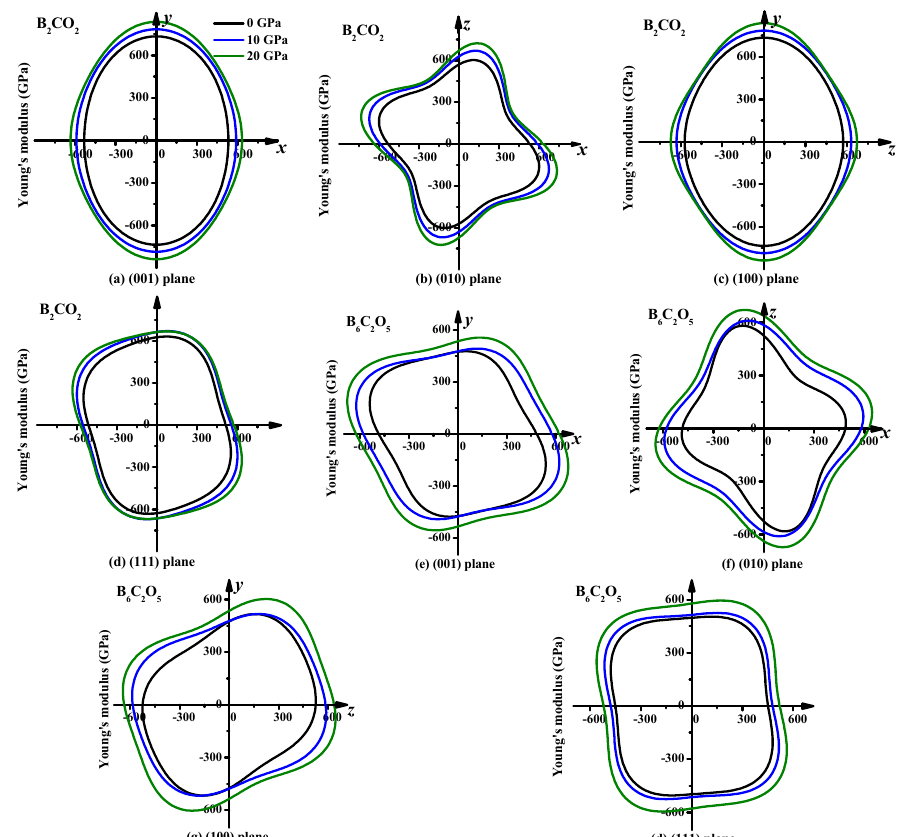
Figure 7. Planar projections of the directional dependence of the Young’s modulus in B 2 CO 2 , ( a ): (001) plane, ( b ): (010) plane, ( c ): (100) plane, and ( d ): (111) plane; and Planar projections of the directional dependence of the Young’s modulus in B 6 C 2 O 5 , ( e ): (001) plane, ( f ): (010) plane, ( g ): (100) plane, and ( h ): (111) plane. Table 3. Calculated the maximum values (in GPa) and minimum values (in GPa) of Young’s modulus and shear modulus and the X max / X min ratio for B 2 CO 2 and B 6 C 2 O 5 .